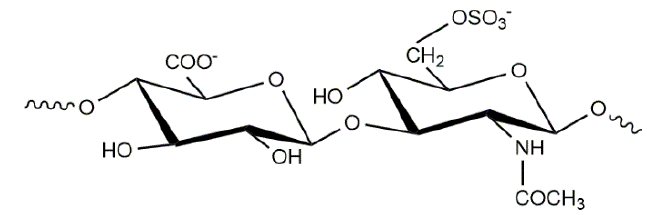
Figure 8. Chemical structure of chondroitin sulfate.